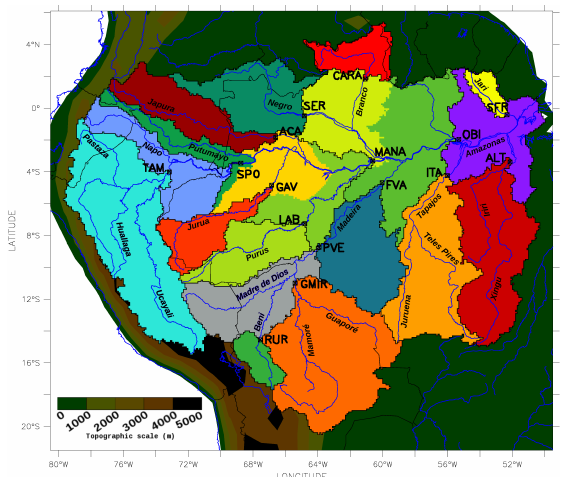
Fig. 2. Map of the Amazon River sub-basins and the main rivers. Fig.2. MapoftheAmazonRiversub-basinsandthemainrivers. LocalizationofthemainOREHYBAMgauge Localization of the main ORE HYBAM gauge stations (see Table 2 stations (see Table 2 for their coordinates). Color is used to distinguish the different sub-basins. Topographic for their coordinates). Color is used to distinguish the different sub- scaleisindicated. basins. Topographic scale is